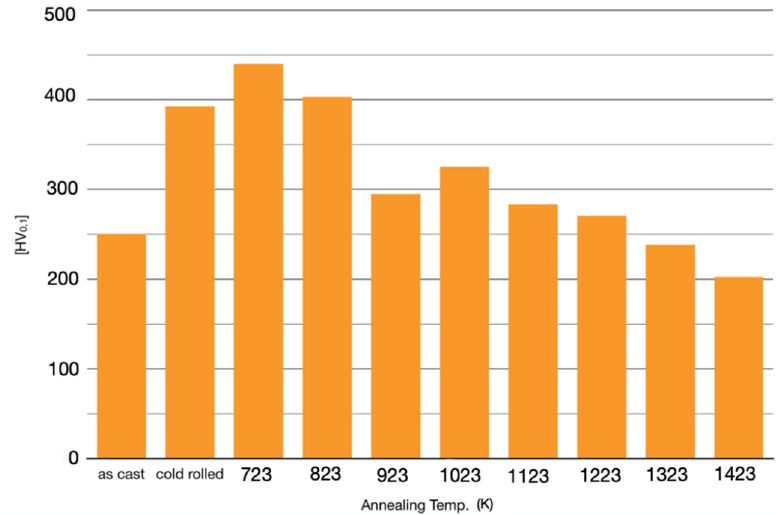
Figure 16. Microhardness of cold-rolled and annealed samples at temperatures from 723 K to 1423 K.